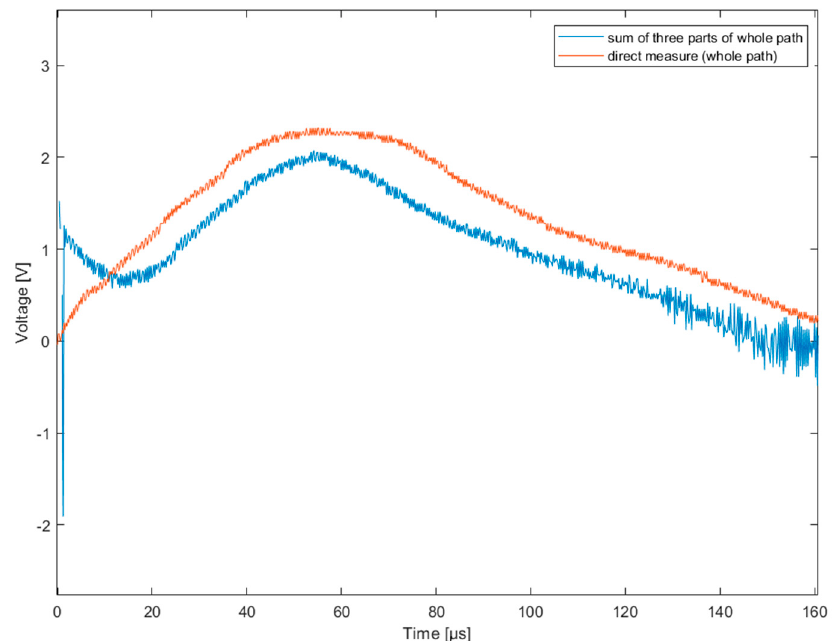
Figure 13. Measured overvoltage and simulated for the same circuits (three blocks). Input in points 1, 2 (motor coil) and output in GPS module communication line (point